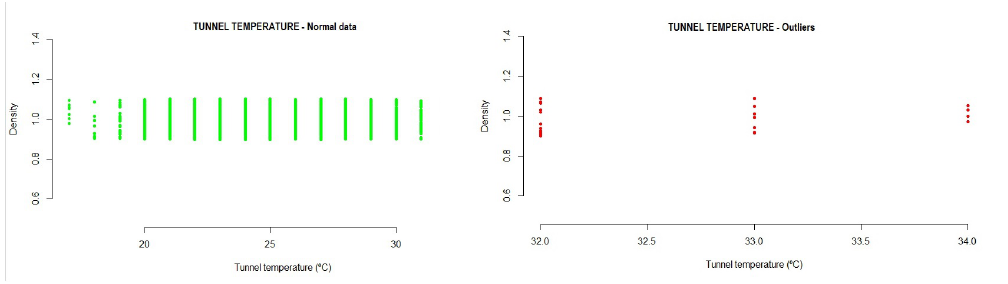
Figure 7. Example of tunnel temperature outliers detected in the testing data.